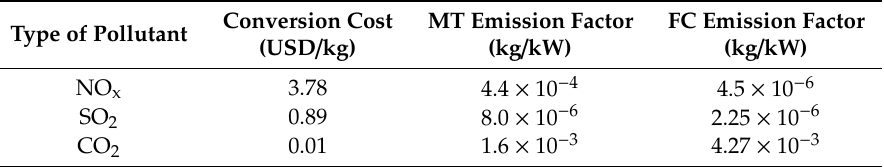
Table 1. Conversion costs of pollutants and emission factors.